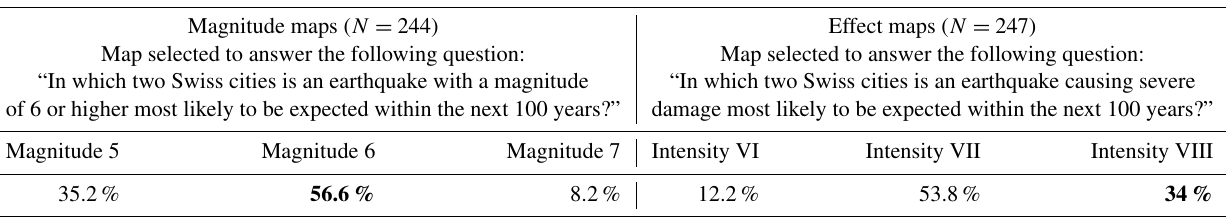
Table 8. Selection of the most suitable magnitude or effect map for answering a given question. The correct answers are highlighted in bold font.